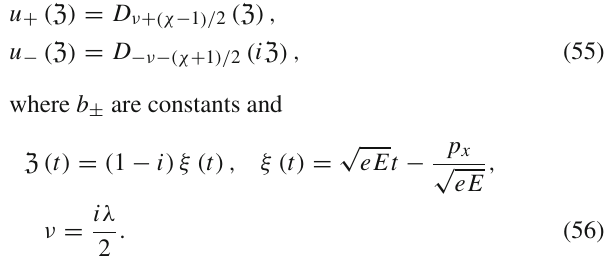
while the asymptotic approximation (47) are represented by dashed lines. The lines labelled with (a), (b) and (c), refers to m τ 2 = 100, 50 and 10, respectively. In both plots, E = 3 E c and the horizontal dashed line denotes the uniform distribution e − πλ which, in this case, is e − π/